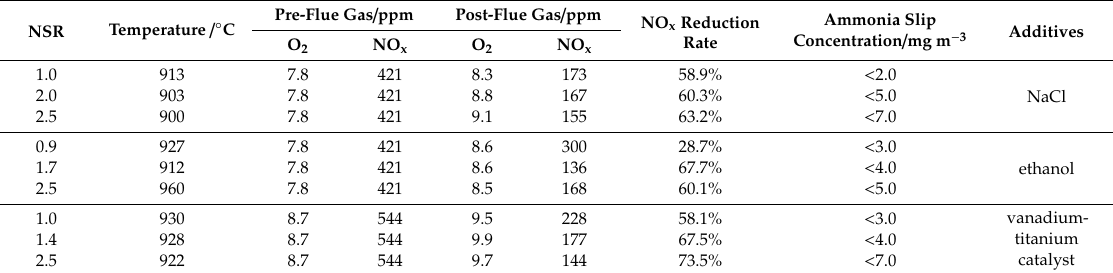
Table 2. E ff ects of additives on the NO x reduction with di ff erent